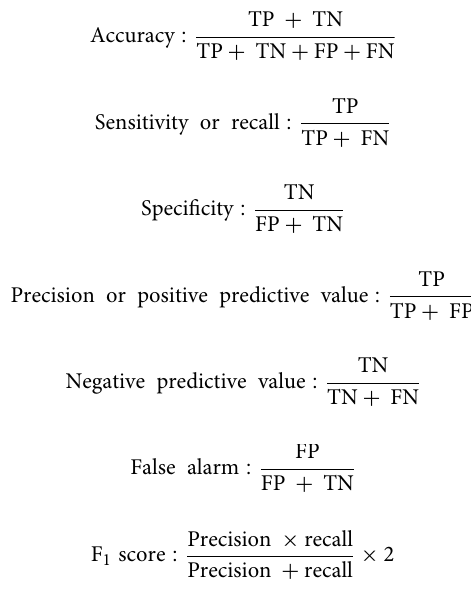
Precision × recall F 1 score : Precision + recall